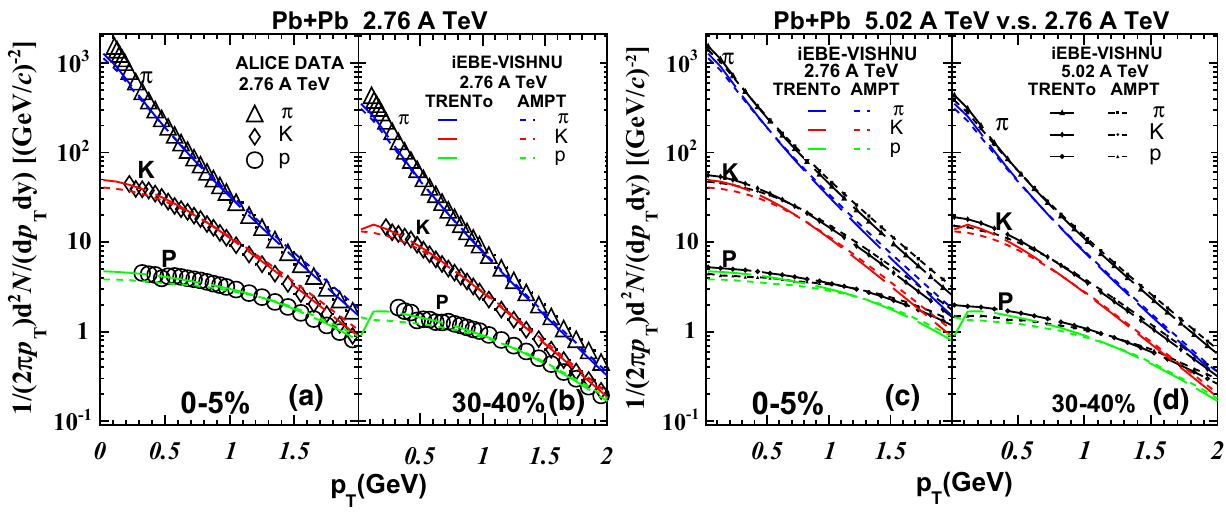
Fig. 3 p T spectra of pions, kaons, and protons in 0–5 and 30–40% Pb + Pb collisions at 2.76 and 5.02 A TeV, calculated from iEBE-VISHNU with TRENTo and AMPT initial conditions. The experimental data at 2.76 A TeV are taken from the ALICE paper